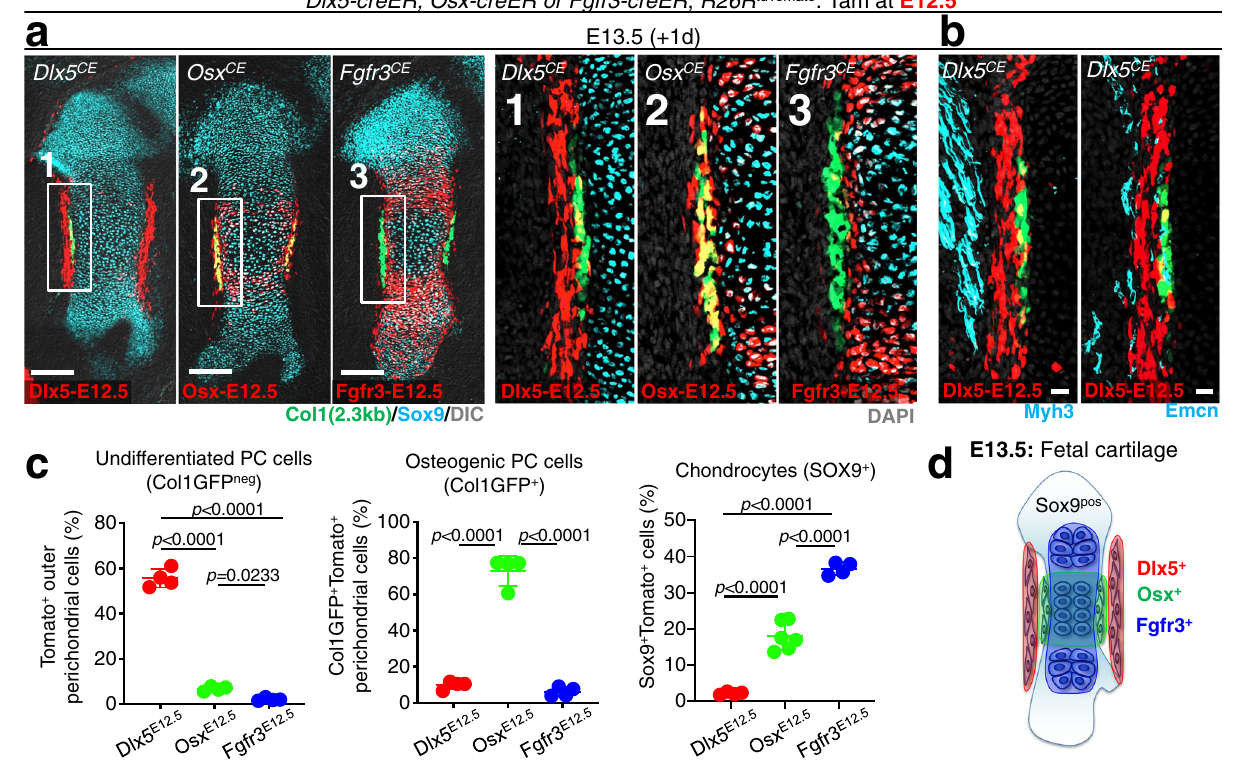
percentage of tdTomato + cells among Col1a1-GFP neg perichondrial cells. Center: percentage of Col1a1-GFP + tdTomato + cells among Col1a1-GFP + osteogenic peri- chondrial cells. Right: percentage of SOX9 + tdTomato + cells among SOX9 + chon- drocytes. n =4 mice per each group. Two-tailed, one-way ANOVA followed by Tukey ’ spost-hoctest.Dataarepresentedasmean±s.d.Exact P valueisindicatedin the fi gures. d Dlx5-creER and Fgfr3-creER can mark mutually exclusive cell popula- tions in the fetal perichondrium and cartilage template, respectively, whereas Osx- creER markscellsthatoverlapwiththosetwocelltypes.Sourcedataareprovidedas a Source Data fi